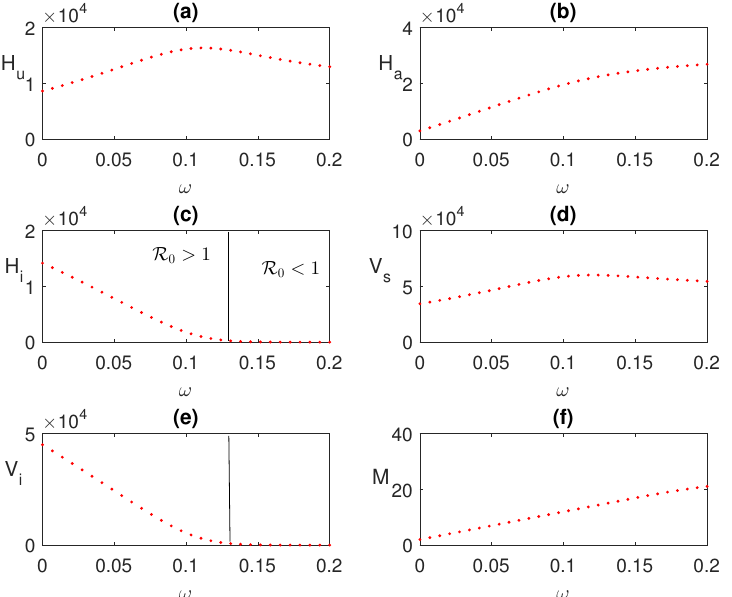
Figure 6. Effect of global awareness is shown varying the parameter ω . Other parameters values are as shown in Figure